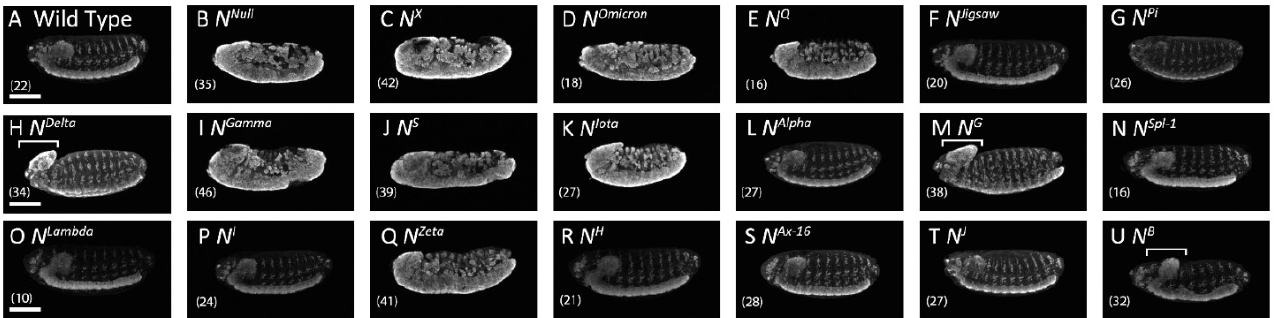
Table 1. Notch missense mutations and their defects.